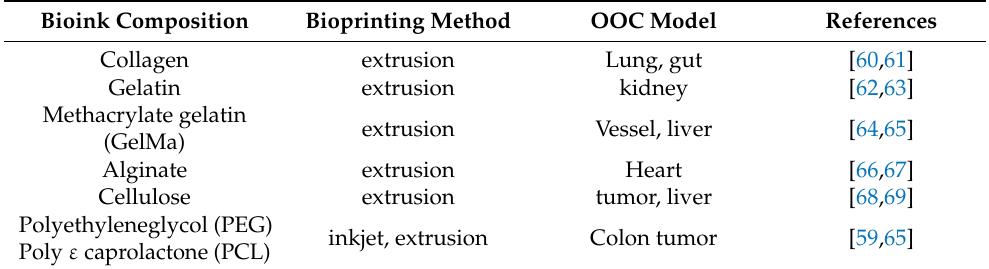
Table 1. The main polymers used as bioinks for OOCs by